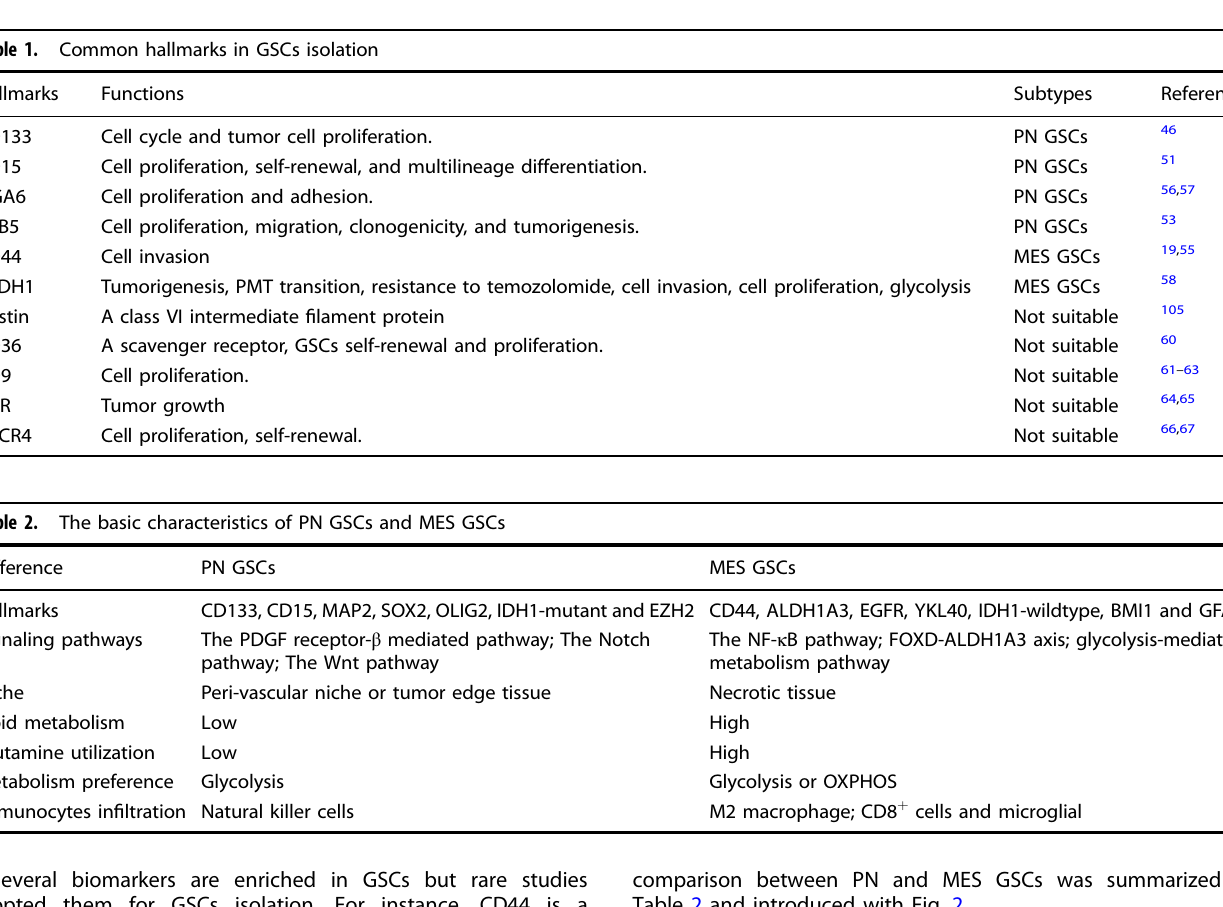
Table 1. Common hallmarks in GSCs isolation Hallmarks